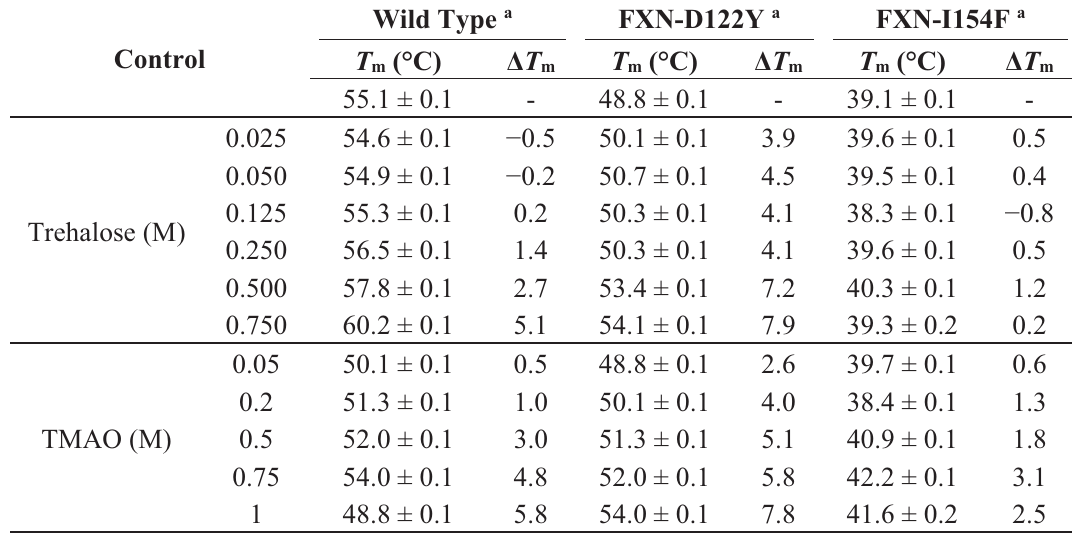
Table 1. Melting temperatures ( T m ) determined by the two state fits to the unfolding curves obtained by DSF experiments. The concentration of frataxin was 4